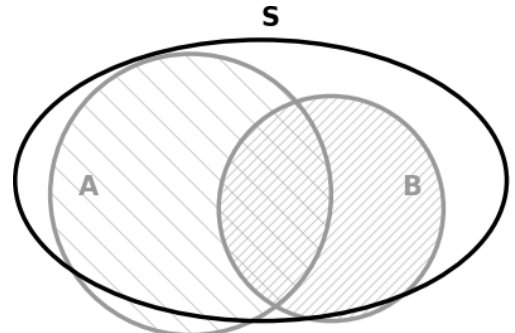
Figure 1. A Venn diagram illustrating set S as the total number of occurred lightning discharges and A and B as the set of discharges observed by independent systems. The intersection of A and B is composed of discharges detected by both A and B. Note that there can be a small portion of false-alarm discharges detected by either system that occur outside set